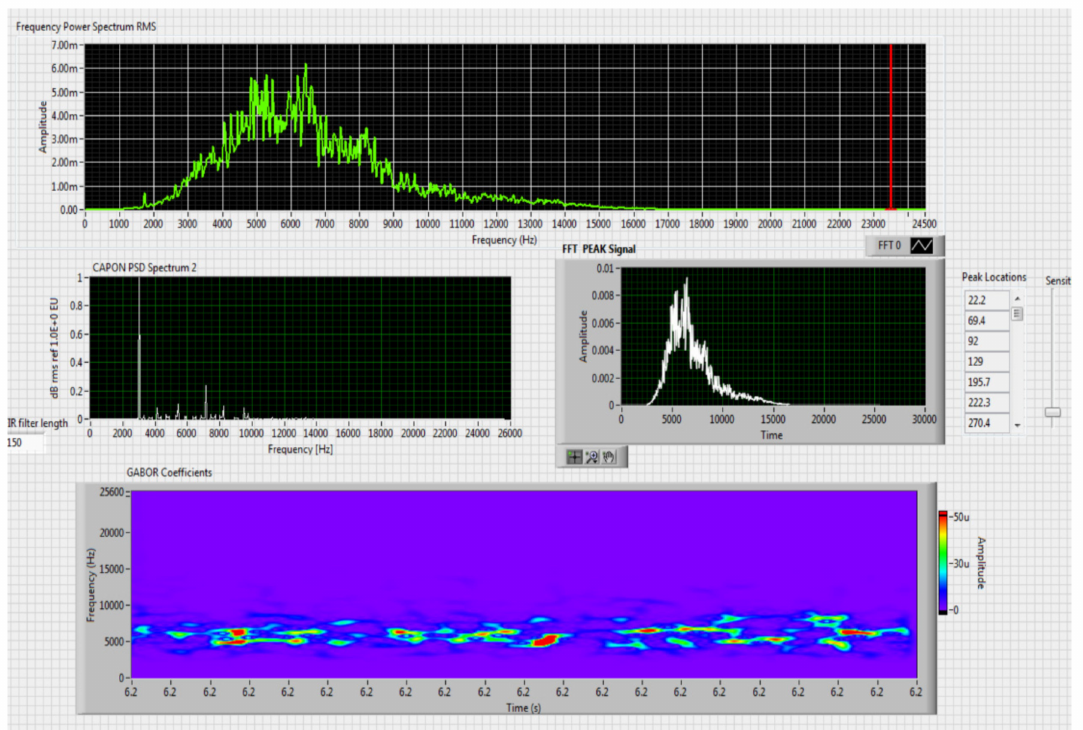
Figure 11. Results obtained for stationary distance 150 m, altitude 4 m.